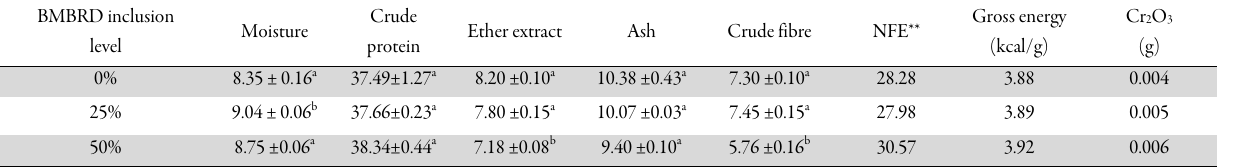
Table 3. Proximate composition, gross energy and chromic oxide contents of the experimental diets BMBRD inclusion level